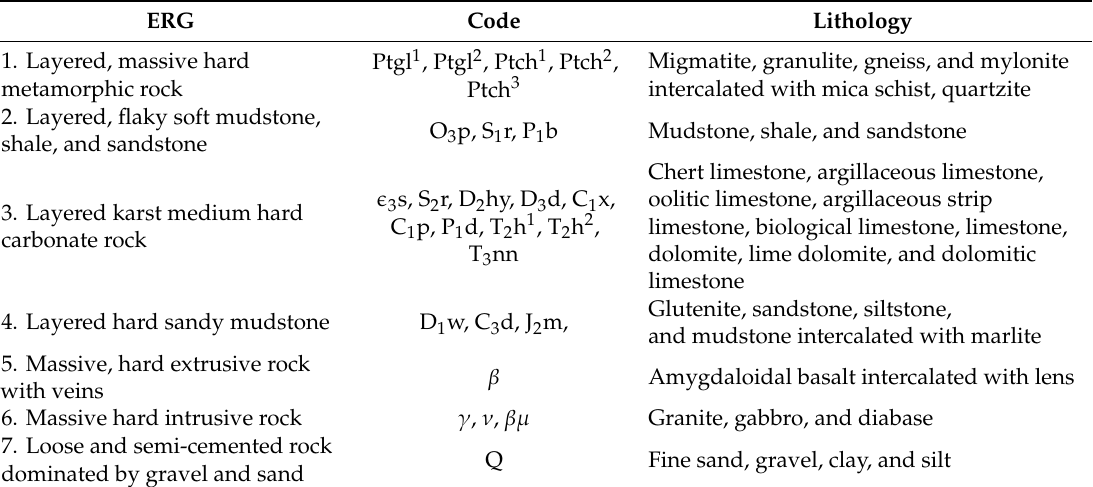
Table 1. Description of the engineering rock groups